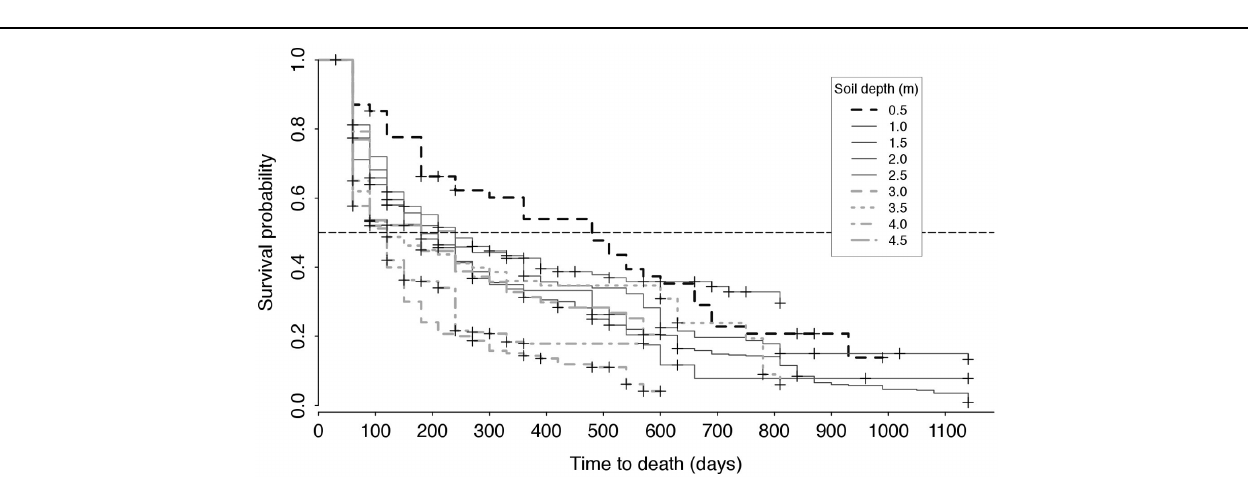
FIGURE 5 | Kaplan–Meier survival probability of roots depending on soil depth (see legend). The dotted horizontal line indicates a survival probability of 50%: the abscissa at which a given Kaplan–Meier curves intersects this line represents the half-life of roots corresponding to this survival curve, i.e., the estimated time required for half of the roots observed at any given point in time to have